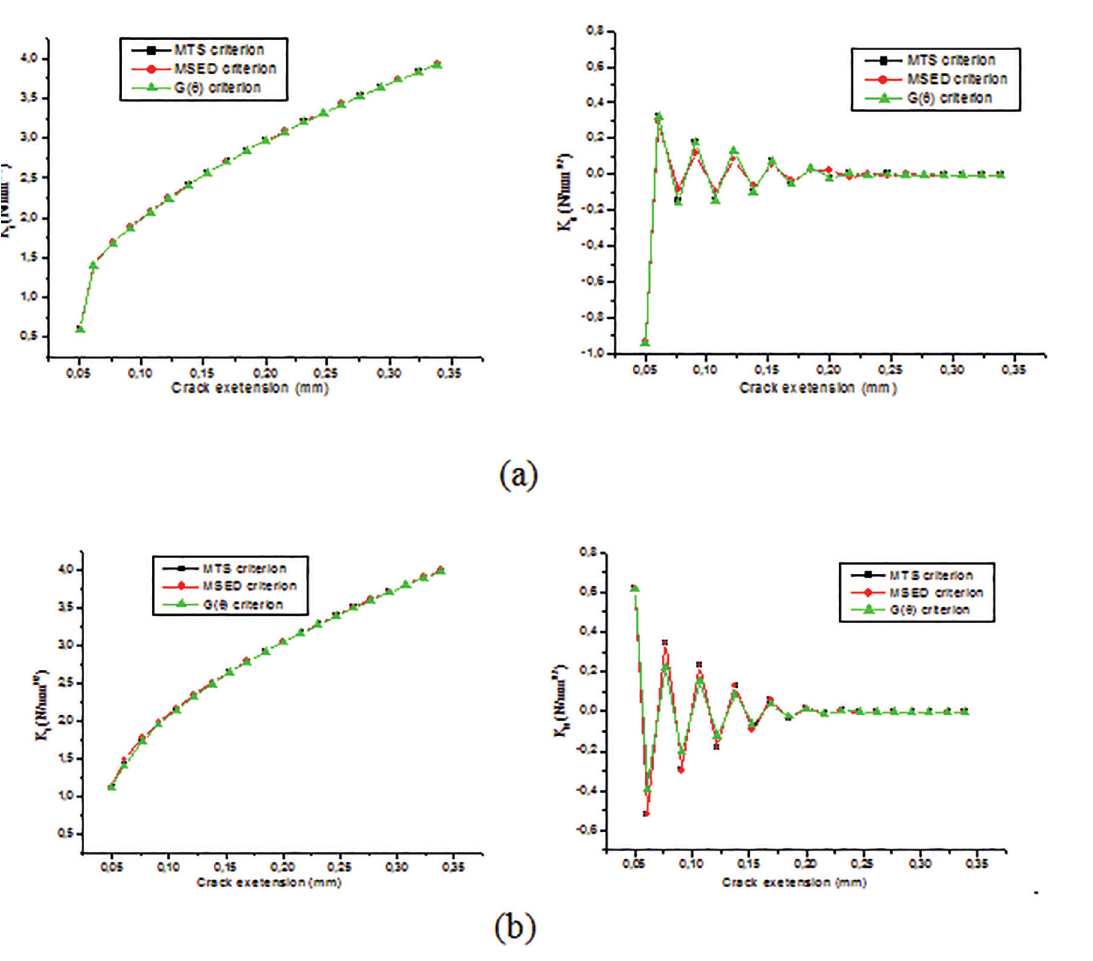
evolution and b) K evolution. I II